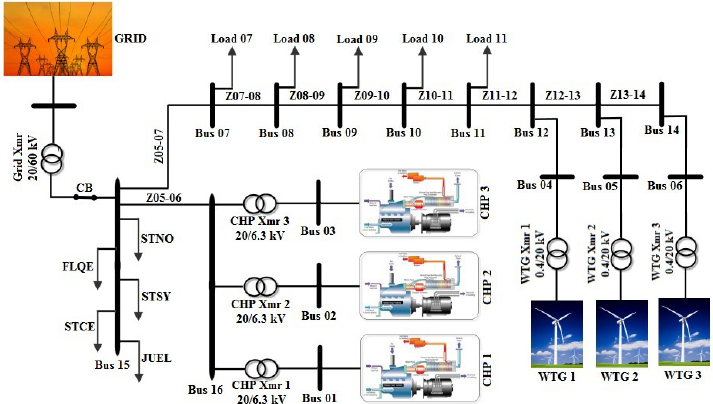
Figure 11. The single line diagram of the proposed real micro-grid (MG).